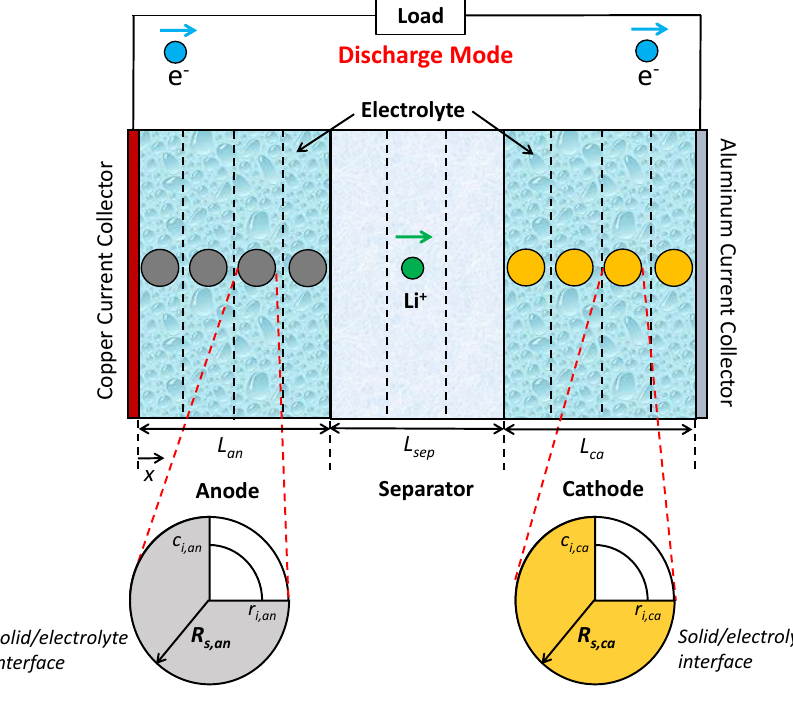
Figure 1. A schematic representation of the Li-ion cell sandwich operation during discharge mode together with finite control volume based discretization